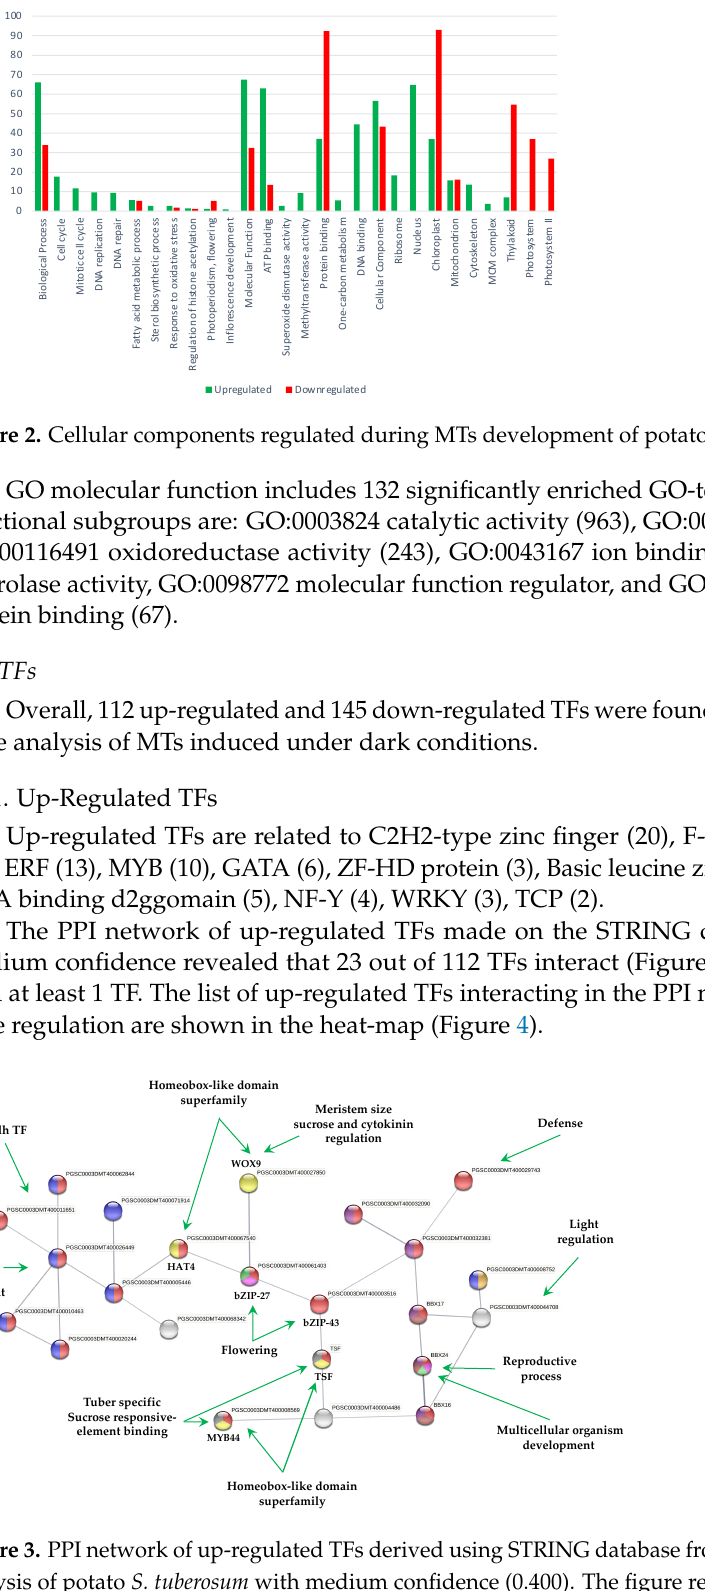
Figure 1. Biological process regulated during MTs development of potato induced in dark.